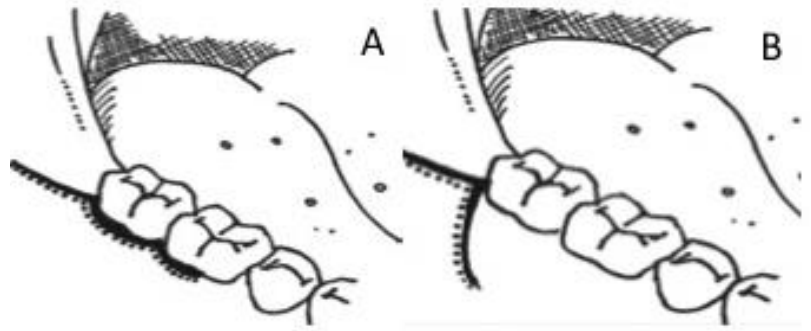
Figure 1. Flap Designs. ( A ) Envelope flap and ( B ) Szmyd